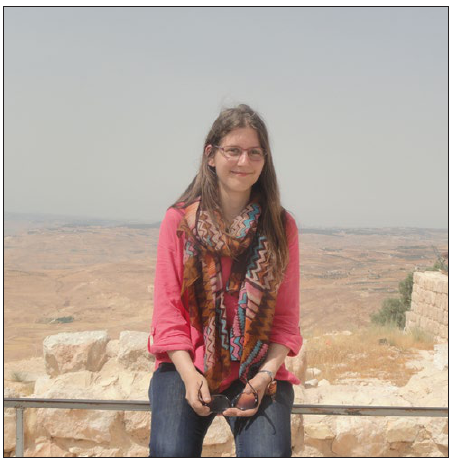
Figure 5: Former IoA student Hélène Rey on Mount Nebo, Jordan (Photo Hélène Rey).